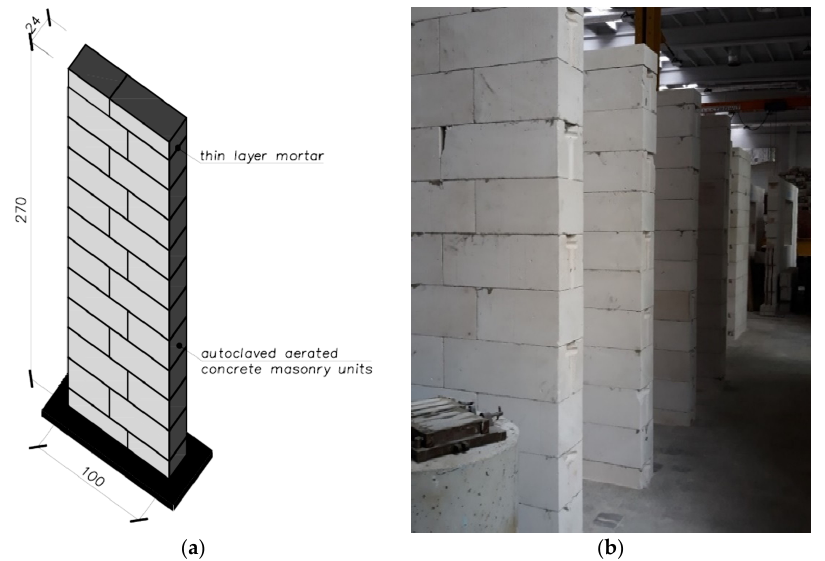
Figure 6. Shape and dimensions of the masonry wall model made of autoclaved aerated concrete units used in compression tests: ( a ) shape and dimensions of the masonry wall model, ( b ) masonry wall models made.